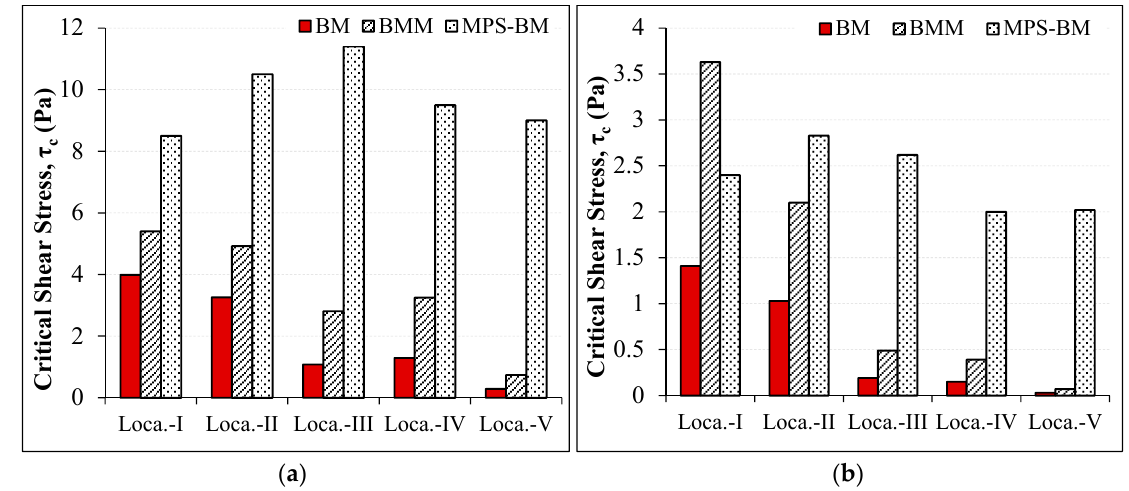
Figure 5. Estimates of critical shear stress ( τ c ) at the five Gist Creek test locations for the: ( a ) lower bank and ( b ) upper bank area (Loca. -I, -II, - III, -IV, and -V). Computational methods: BM, BMM, and MPS-BM were compared.